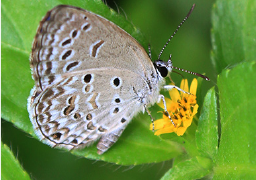
Image 48. Bush Hopper Ampittia discorides